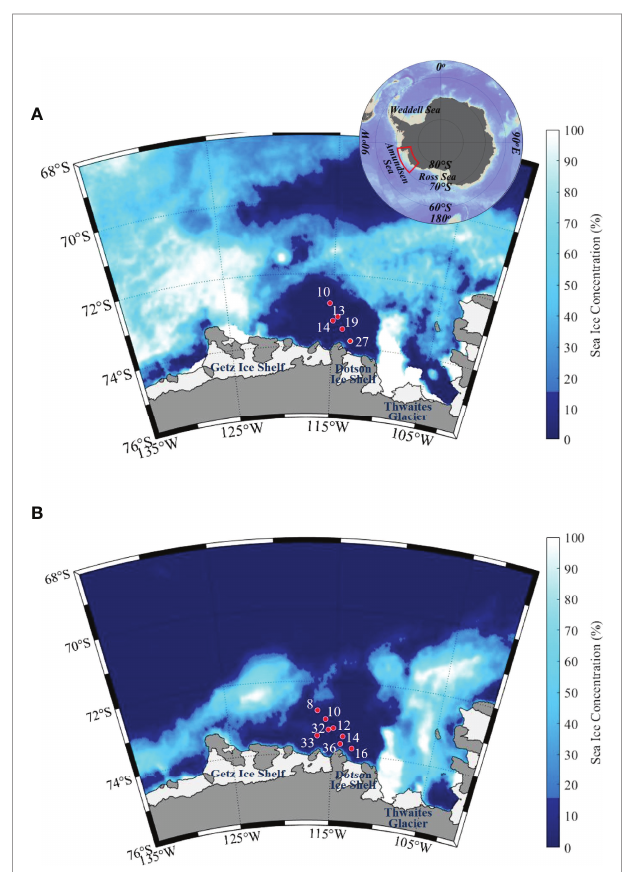
FIGURE 1 | Maps showing sea ice coverage and sampling sites in the ASP during the (A) ANA04 and (B) ANA06